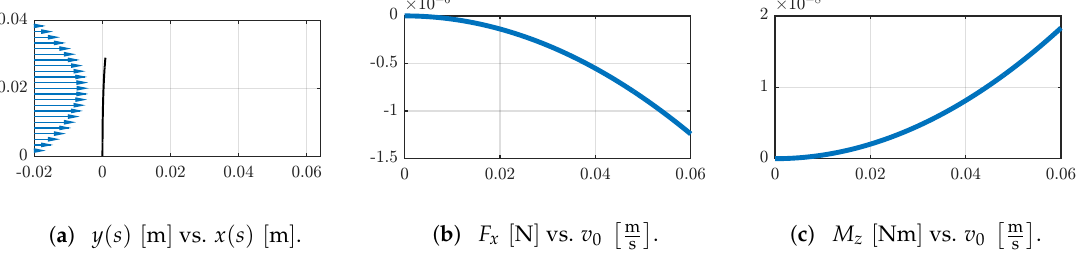
Figure 9. ( a ) The qualitative flow velocity profile v ( y ) (blue) and the deformed shapes are shown for v 0 = 0.06 m . Change of the support reactions ( b ) F x and ( c ) M z in dependence on the flow velocity v 0 . s Example 2. Air Flow inside a Rectangular Duct.